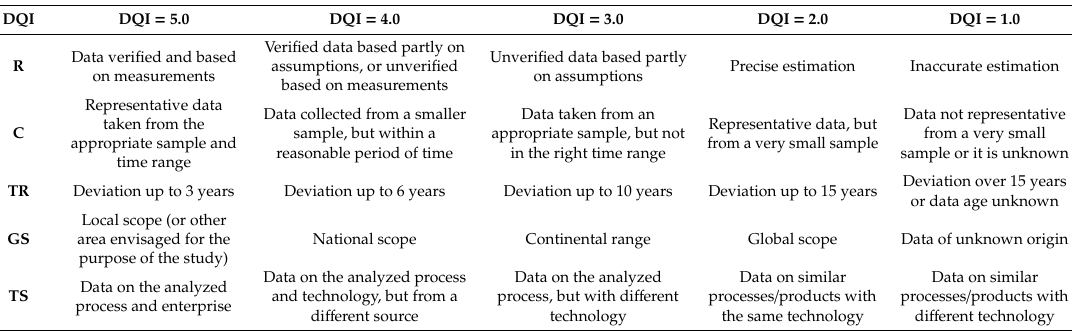
Table 1. Pedigree matrix [56,60].